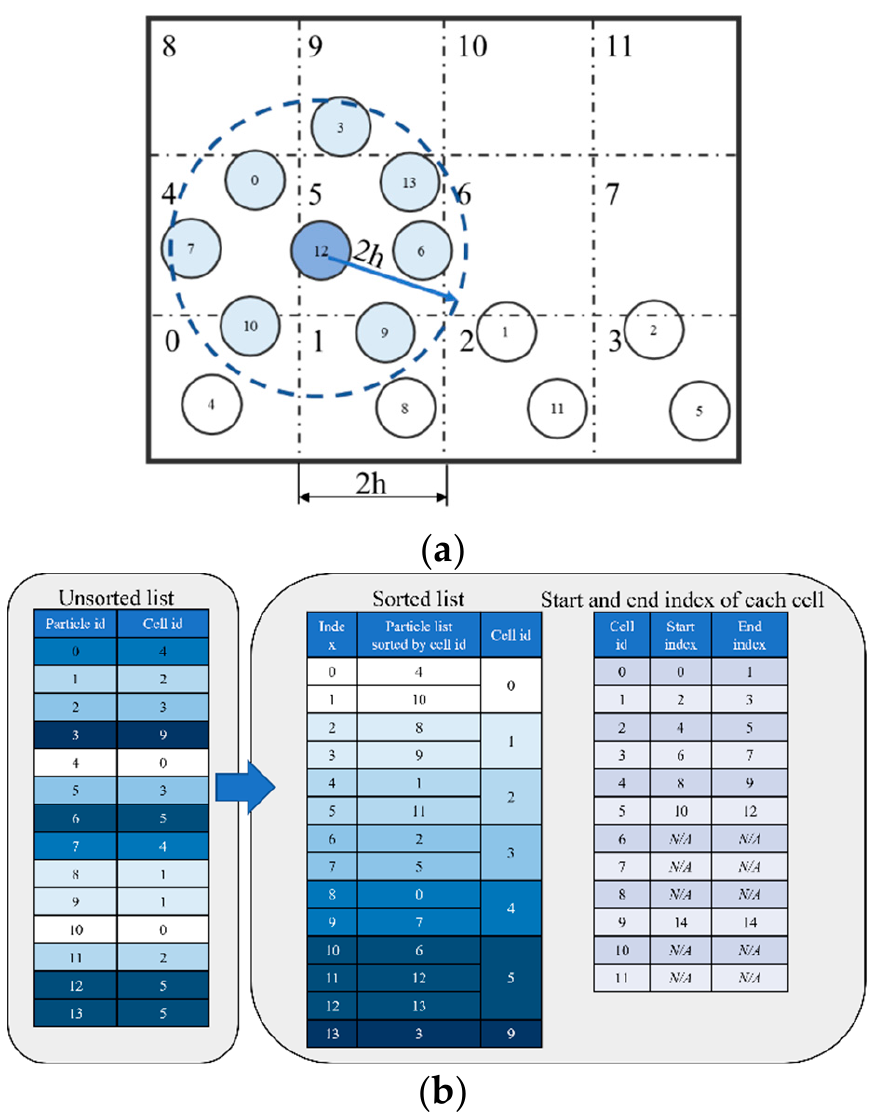
Figure 5. Neighbor particle search algorithm. ( a ) Cell division in 2D; ( b ) sorted neighbor list.